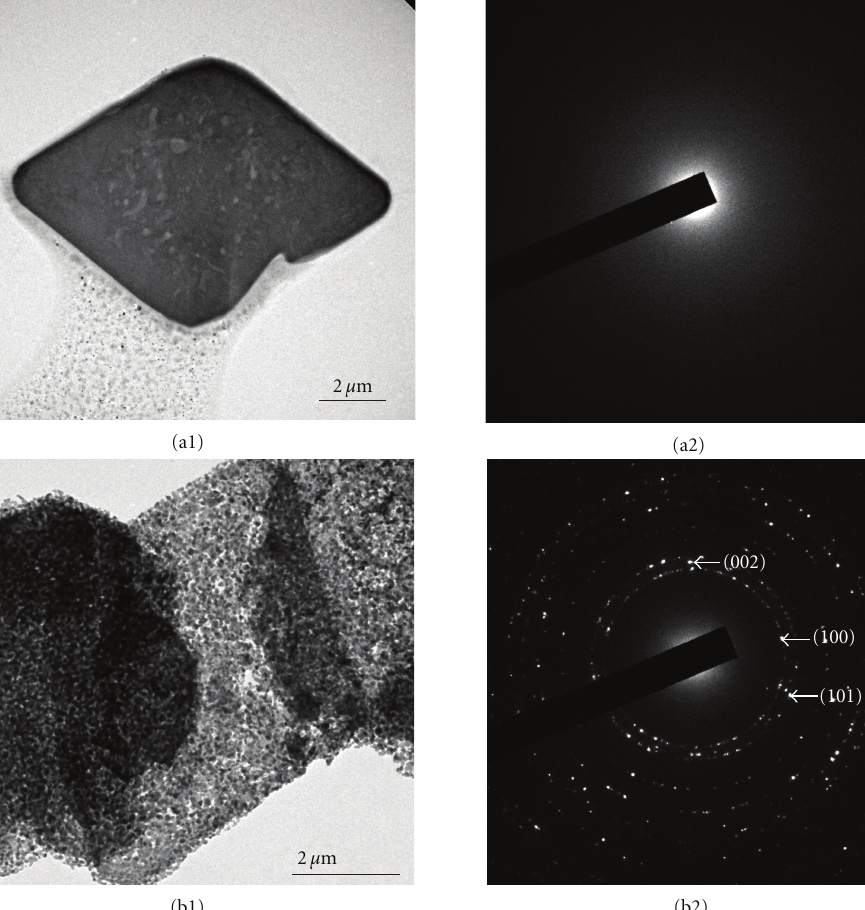
Figure 5: SAED graphs and FE-TEM images of ZnO flakes: (a1) and (a2) samples dried at 160 ◦ C; (b1) and (b2) samples calcinated at 500 ◦ C.